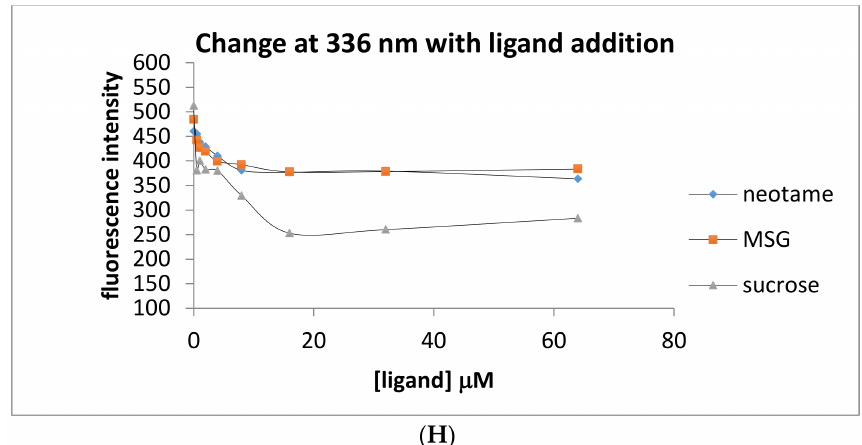
Figure 3. Intrinsic fluorescene emission spectra (excitation at 280 nm) of His tagged human and mouse T1R2 ATD. Panel ( A ) human T1R2 ATD ± neotame; ( B ) human T1R2 ATD ± sucralose; ( C ) human T1R2 ATD ± MSG; ( D ) changes in intrinsic fluorescence signal at 336 nm in the presence of human T1R2 ATD and increasing concentrations of either neotame, sucralose or MSG; ( E ) mouse T1R2 ATD ± sucrose; ( F ) mouse T1R2 ATD ± neotame; ( G ) mouse T1R2 ATD ± MSG; ( H ) changes in